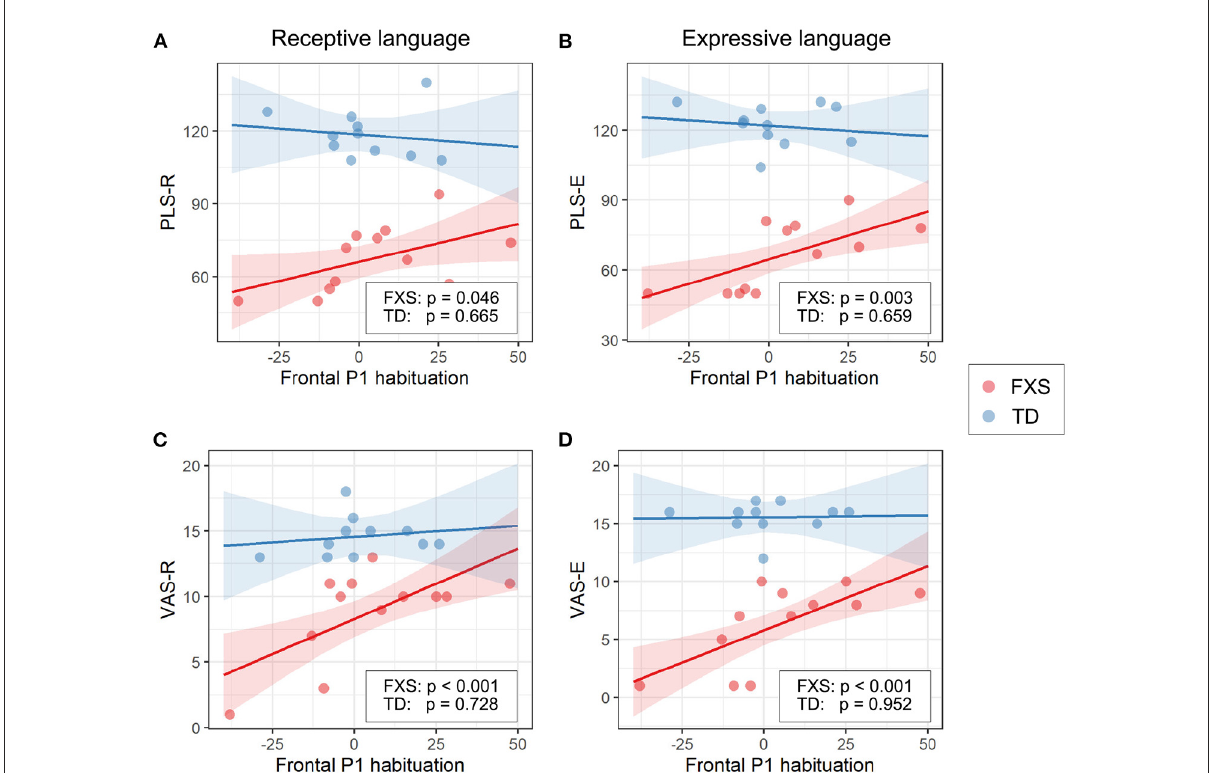
FIGURE7 Association between the frontal P1 habituation (ST1 – ST5) and (A) PLS-R, (B) PLS-E, (C) VAS-R, and (D) VAS-E in Model 1. The lines and shaded areas denote the prediction lines and their 95% confidence interval estimated by the marginal effect. The scattered dots represent individual data. The unadjusted p -value of marginal effect for each group is shown in the legend.